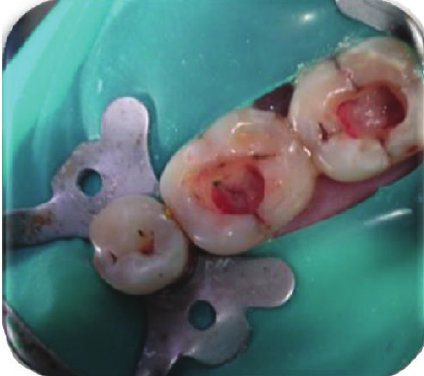
Figure 16: Placement of PRF membrane over the radicular pulp: 36, 37.